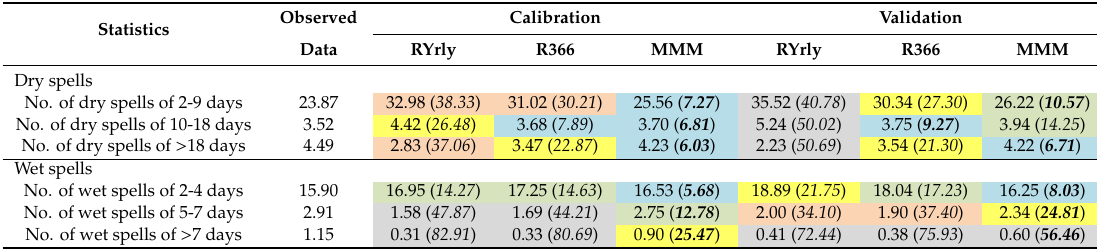
Table 4. Average number of dry and wet spells in a year. Relative root mean square error (Rel. RMSE) is presented in brackets (Model case: